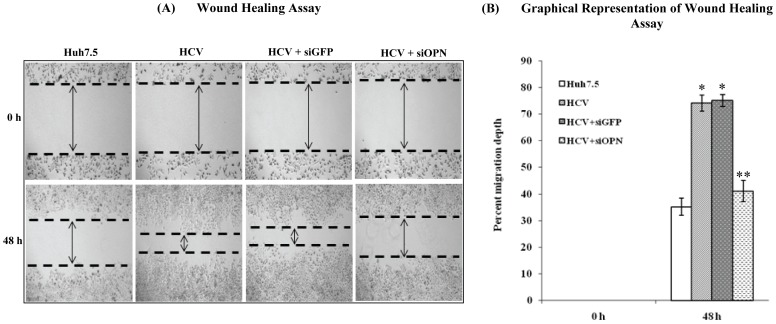

HCV induces hepatoma cells migration.
(A) HCV-infected cells (from the same pool of figure 2A) were transfected with
                            siGFP and siOPN and migration was examined by wound healing assay.
                            Images were taken at 0 h and 48 h postwounding. Arrows indicate the
                            wound of monolayer cells scratched using pipette tips. The results shown
                            are representative of three independent experiments. (B) The percent
                            migrated depth of above cells was measured in three independent
                            experiments represented by bar diagram. *denotes p<0.05 compared
                            to mock-infected Huh7.5 cells. **denotes p<0.05 compared to
                            HCV-infected cells transfected with siGFP.